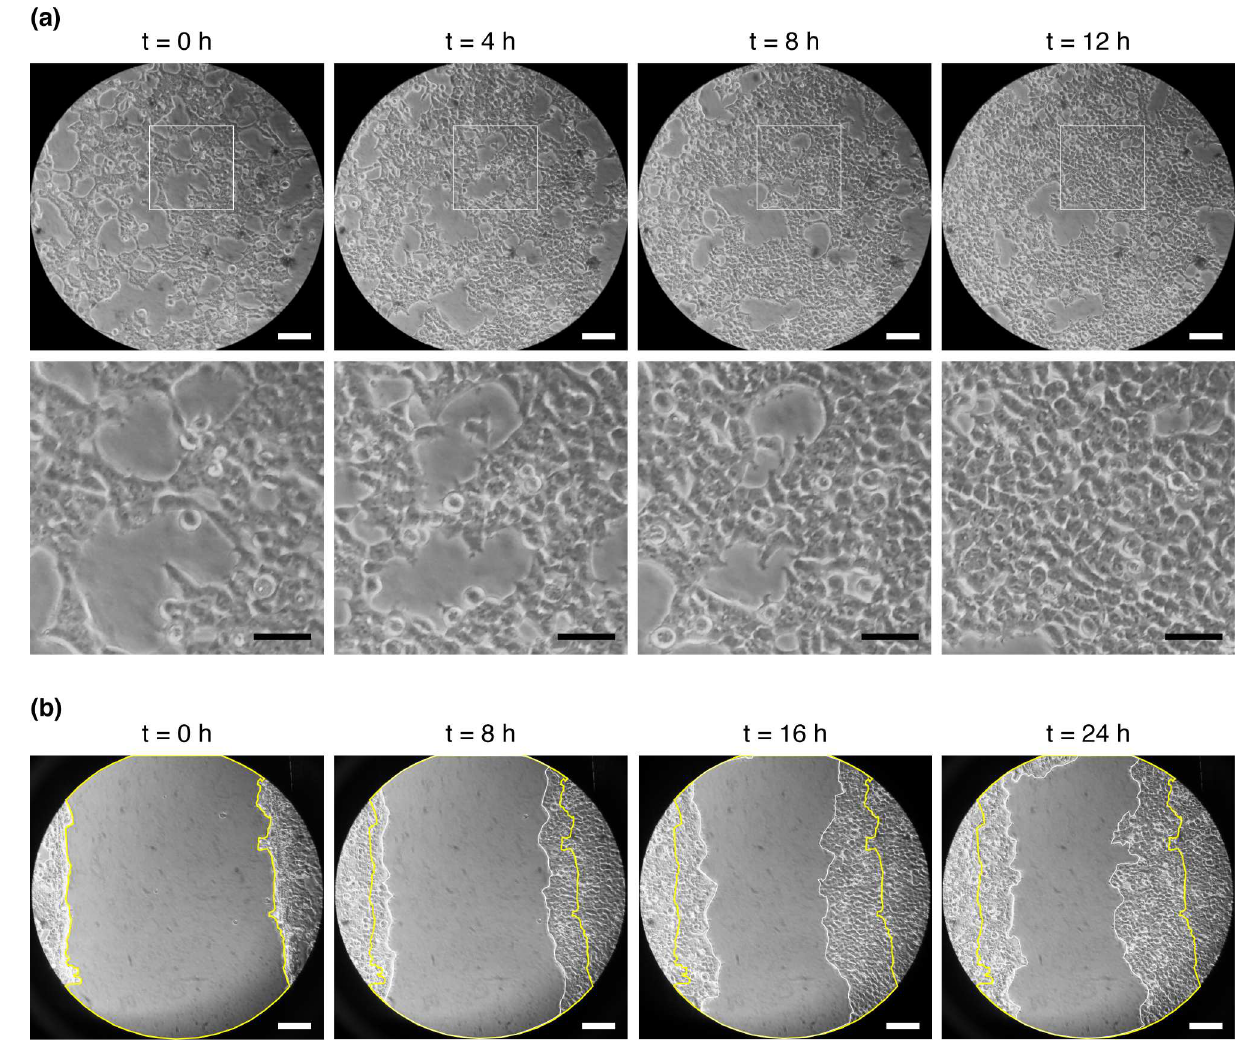
Fig 5. Time-lapse imaging using the ATLIS. (a) HEK cells grown in a 6-well plate were monitored using time-lapseimagingfor 12 h. Scale bars: white 100 μ m; black 50 μ m. (b) Scratch-wound assay performed with HEK cells grown in a 6-well plate. Yellowlines delimit the original wound area whilewhite lines show the collectivecell migration front at each time point. Scale bars represent 100 μ m. For both experiments the ATLIS was mountedon a Nikon TMS microscope using the 20X objectivetogetherwith 10X magnification in the eyepiece,and images were capturedusing a SamsungGalaxy S